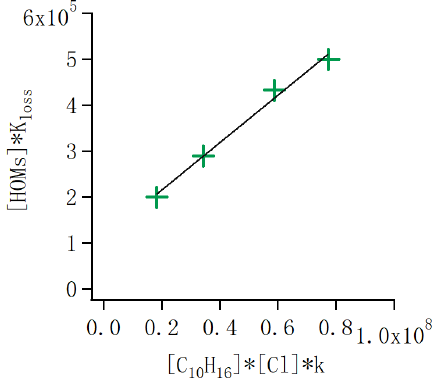
Figure 10. HOM loss rate ([HOM] × Kloss) as a function of the alpha-pinene oxidation rate. In steady state the loss rate equals the formation rate, and thus the slope of the points gives the molar yield of HOM from the alpha-pinene + Cl reaction. The data correspond to the conditions with one, two, four and seven lights switched on in the chamber. The slope indicates an average molar yield of HOMs of